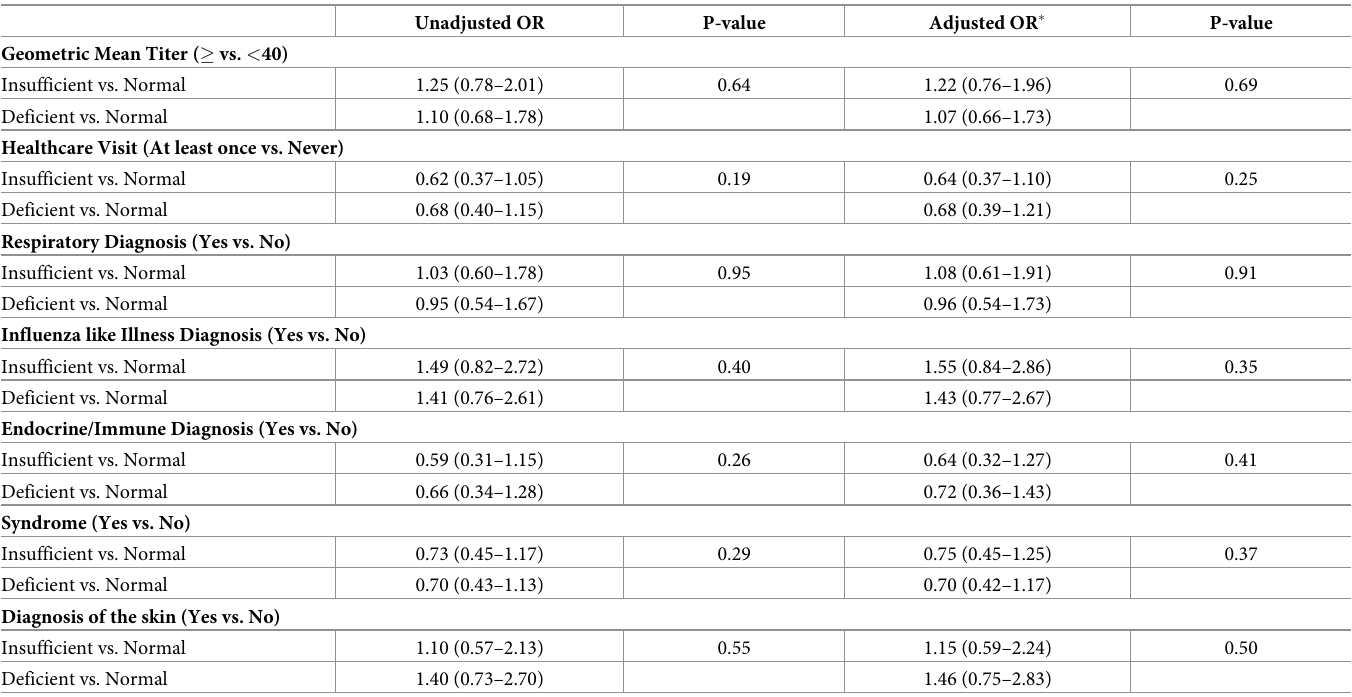
Table 4. Association between clinical outcomes and vitamin D